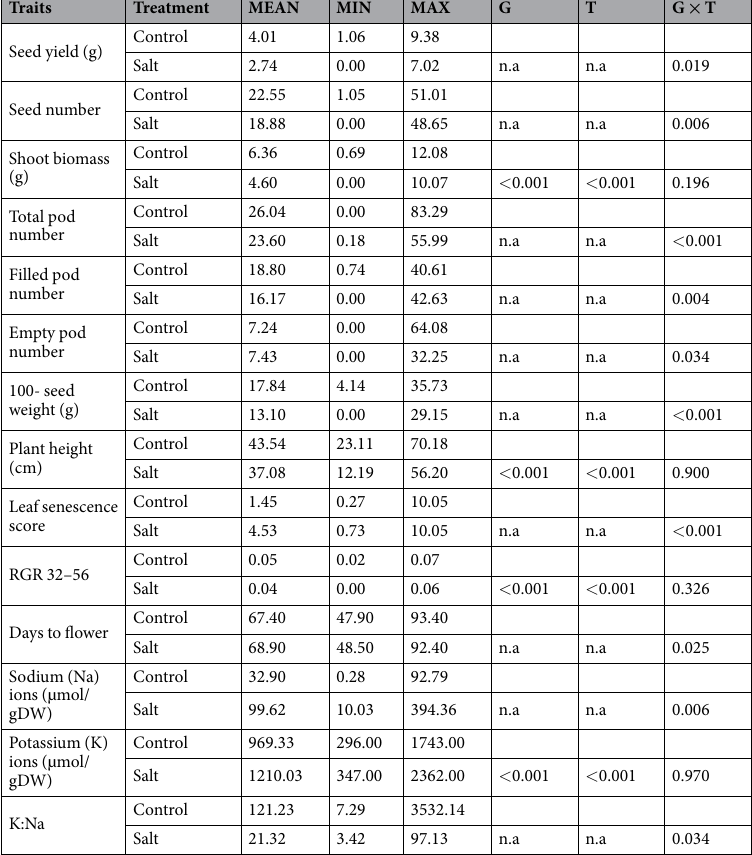
Table 1. Overall values of mean, minimum, maximum, and P-value for effects of genotypes (G), treatments (T) and genotype by treatment interaction (G × T) from the chickpea Reference Set in the glasshouse under salt and control conditions. All measurements are on a pot basis. Number of observation ranged from 201–244. P-values that are not applicable because G × T is significant are indicated by